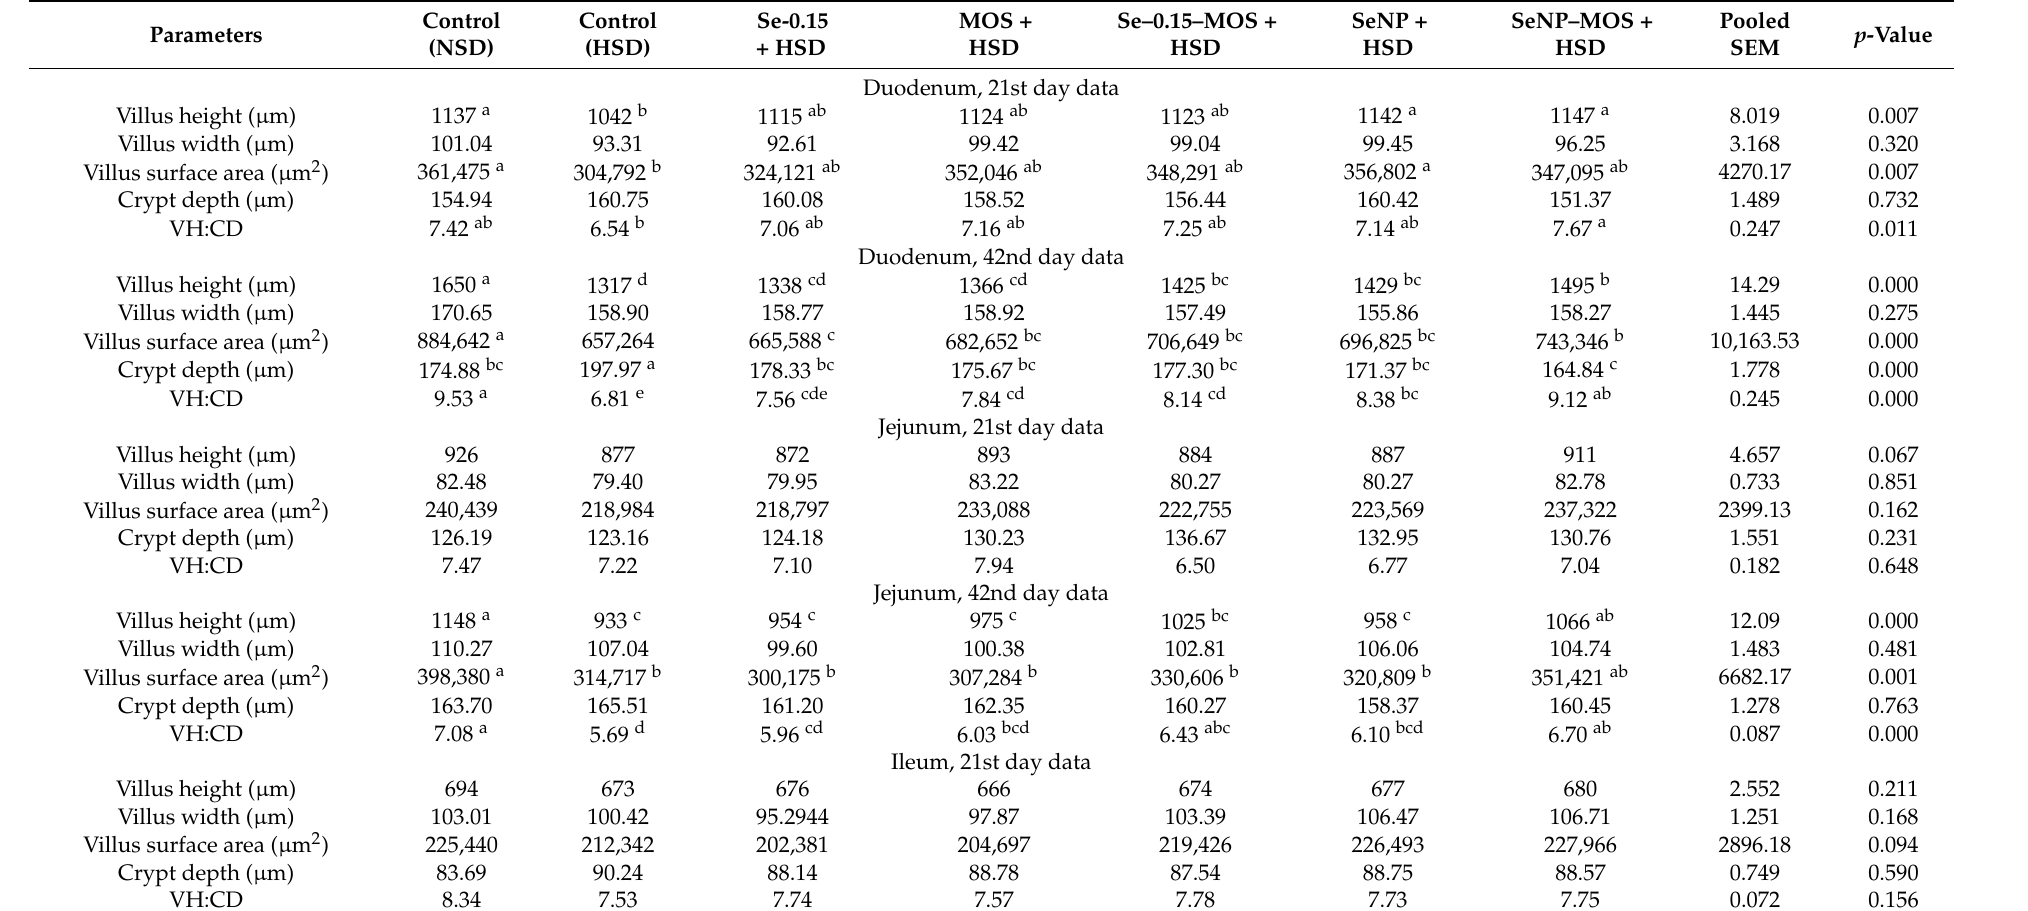
Table 6. Effect of selenium nanoparticles–MOS supplementation on the histomorphometric parameters in duodenum, jejunum and ileum broilers chickens reared under higher stocking